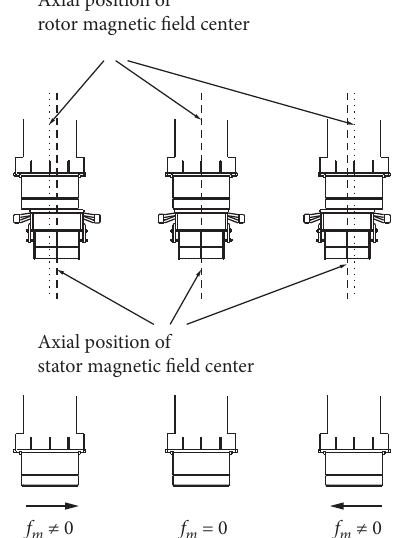
Figure 3: Force on rotor due to the difference between axial position of stator and rotor magnetic field centers.